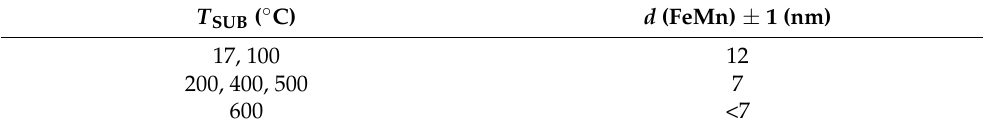
Table 1. Average grain sizes of the FeMn (111) phase at various substrate temperatures during deposition. T SUB ( ◦